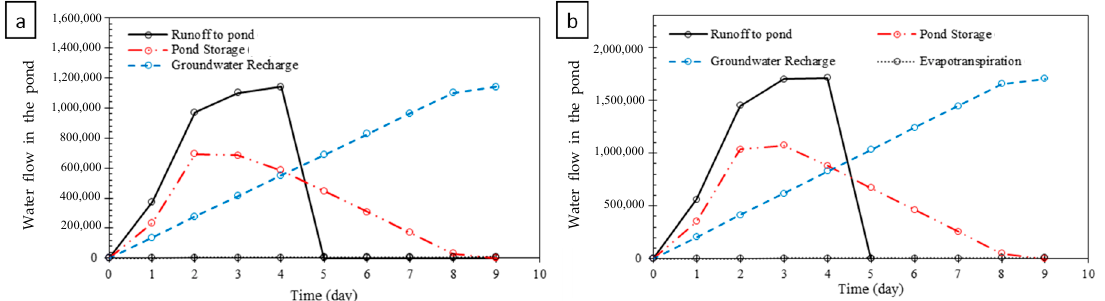
Figure 10. Water flow balance inside the pond: ( a ) Scenario 1: 50-year return period ( b ) Scenario 2: 100-year return period.